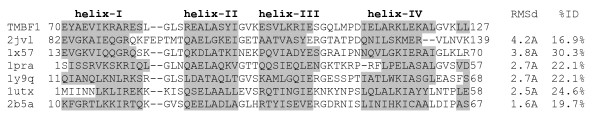
Structural superimposition of the conserved helix-turn-helix (HTH) domains. The structural superimposition was performed using the CE method [72]. Alpha helical structural elements are highlighted by grey shading according to DSSP [73]. The PDB IDs are: 2jvl, C-terminal domain of MBF1 (Trichoderma reesei); PBD ID: 1x57, EDF-1 (human Multiprotein bridging factor 1 α); PDB ID: 1pra, DNA-biding domain (residues 1 to 69) of the bacteriophage 434 repressor; PDB ID: 1y9q, HTH_3 family transcriptional regulator (Vibrio cholerae); PDB ID: 1utx, CYLR2, Transcriptional repressor of cytolysin operon (Enterococcus faecalis); PDB ID: 2b5a, C.BCLI, control element of the BCLI restriction modification system (Bacillus caldolyticus).